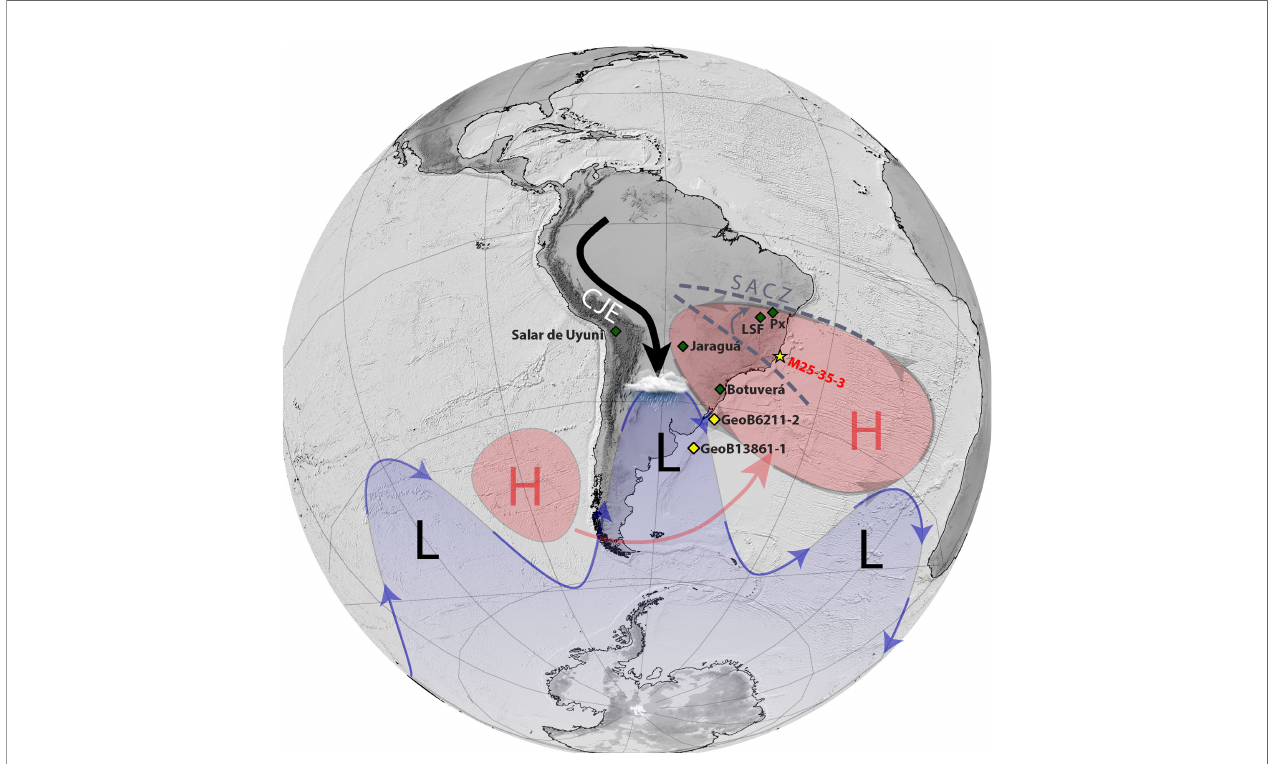
FIGURE 5 | Schematic illustration of atmospheric circulation patterns and rainfall anomalies in South America during Heinrich Stadial at ~16 ka. The blue shaded area marks the low-pressure system related to the steady eastward propagating Rossby wave train. High-pressure systems propagate northward as they pass the Andes (indicated by the red arrow). The quasi-stationary system that occurred at ~16 ka during HS1 foster a subtropical high-pressure system across South America (red area above South America). Substantial moisture transport via the Chaco Jet Event (CJE) con fi guration (black arrow) enhances rainfall in southern southeastern South America. Under this situation, the South Atlantic Convergence Zone (SACZ) was likely displaced northward relative to its modern position. Green and yellow diamonds indicate terrestrial and marine previously published precipitation records respectively. Px, Paixão Cave; LSF, Lapa Sem Fim Cave The yellow star marks Core M125-35-3 (this